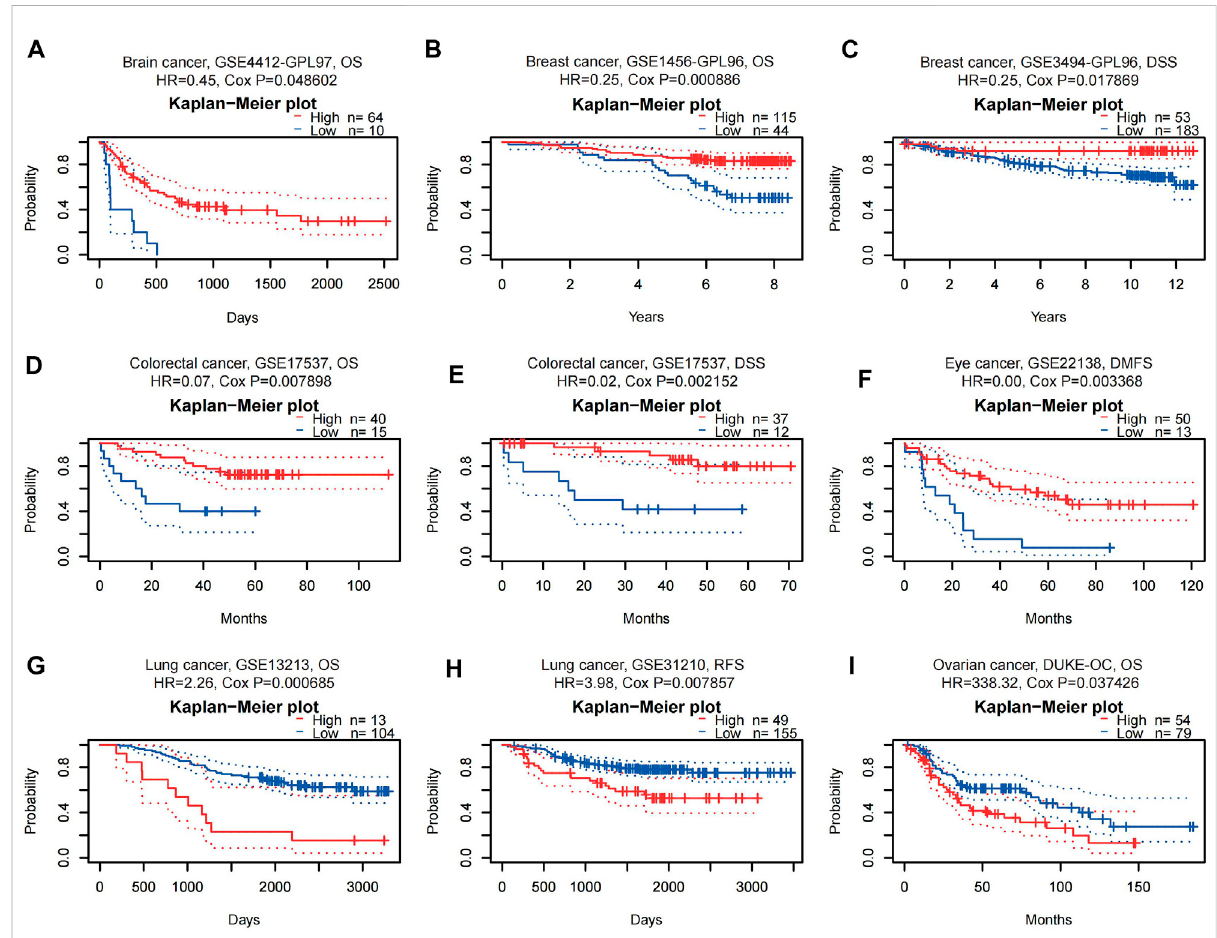
FIGURE 2 Kaplan-Meier survival curves comparing high and low expression of WTAP in different cancer types in PrognoScan. (A) OS ( n = 74, cutpoint = 0.14)inbraincancercohortCSE4412-GPL97. (B,C) OS( n =159,cutpoint=0.43)andDSS( n =236,cutpoint=0.77)inbreastcancercohortGSE1456- GPL96andGSE3494-GPL96. (D,E) OS( n =55,cutpoint=0.25)andDSS( n =49,cutpoint=0.24)incolorectalcancercohortGSE17537. (F) DMFS( n = 63,cutpoint=0.21)ineyecancercohortGSE22138. (G,H) OS( n =117,cutpoint=0.89)andRFS( n =204,cutpoint=0.76)inlungcancercohort GSE13213 and GSE31210. (I) OS ( n = 133, cutpoint = 0.58) in ovarian cancer cohort DUKE-OC. OS, overall survival; DSS, disease-speci fi c survival; DMFS, distant metastasis-free survival; RFS, relapse-free